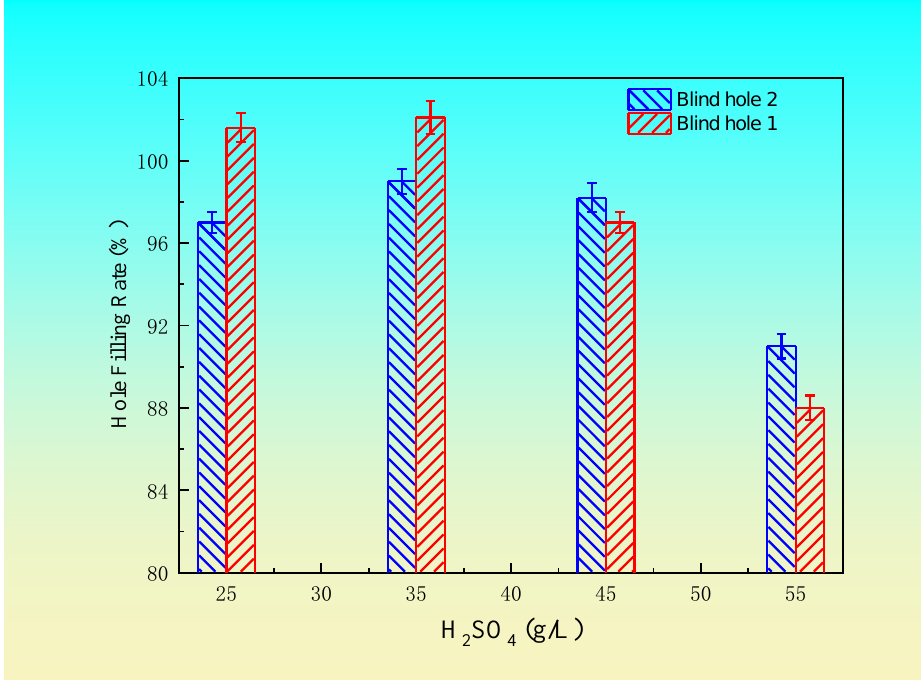
Figure 5. Change in the hole filling rate with sulfuric acid concentration. The relationships between the concentration of CuSO 4 ·5H 2 O and H 2 SO 4 and the plating solution formula for the blind hole with a diameter of 100 μm and a depth of 50 μm are shown in Figure 6. For the blind hole with a diameter of 100 μm and a hole depth of 50 μm, within a certain range of plating solution formula, such as a 45~60 mg/L Cl - concentration, 0.8~1.2 mL/L brightener concentration, 10~16 mL/L leveling agent, and